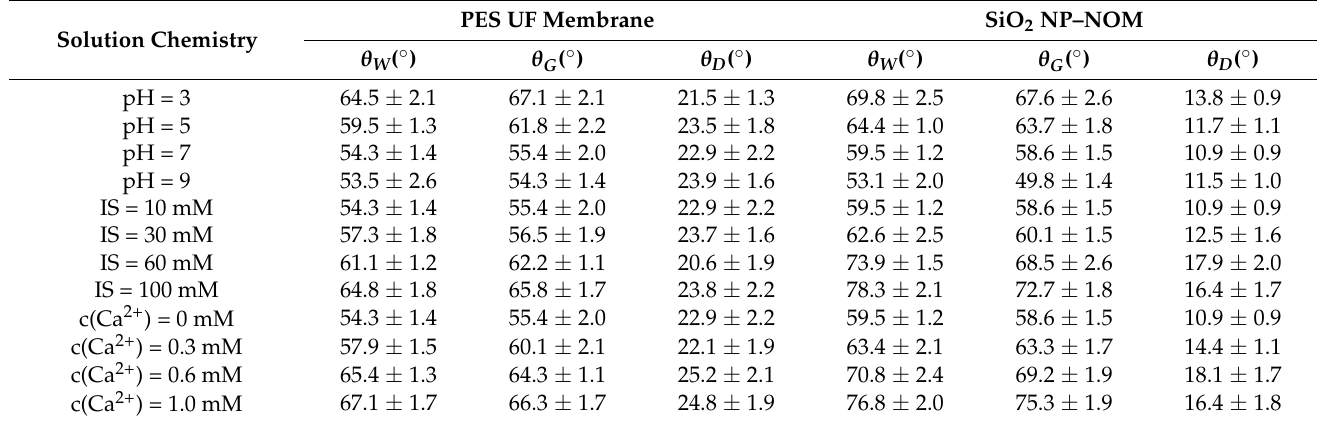
Table 1. Measured contact angles of UF membrane and SiO 2 NP–NOM mixture at different solution